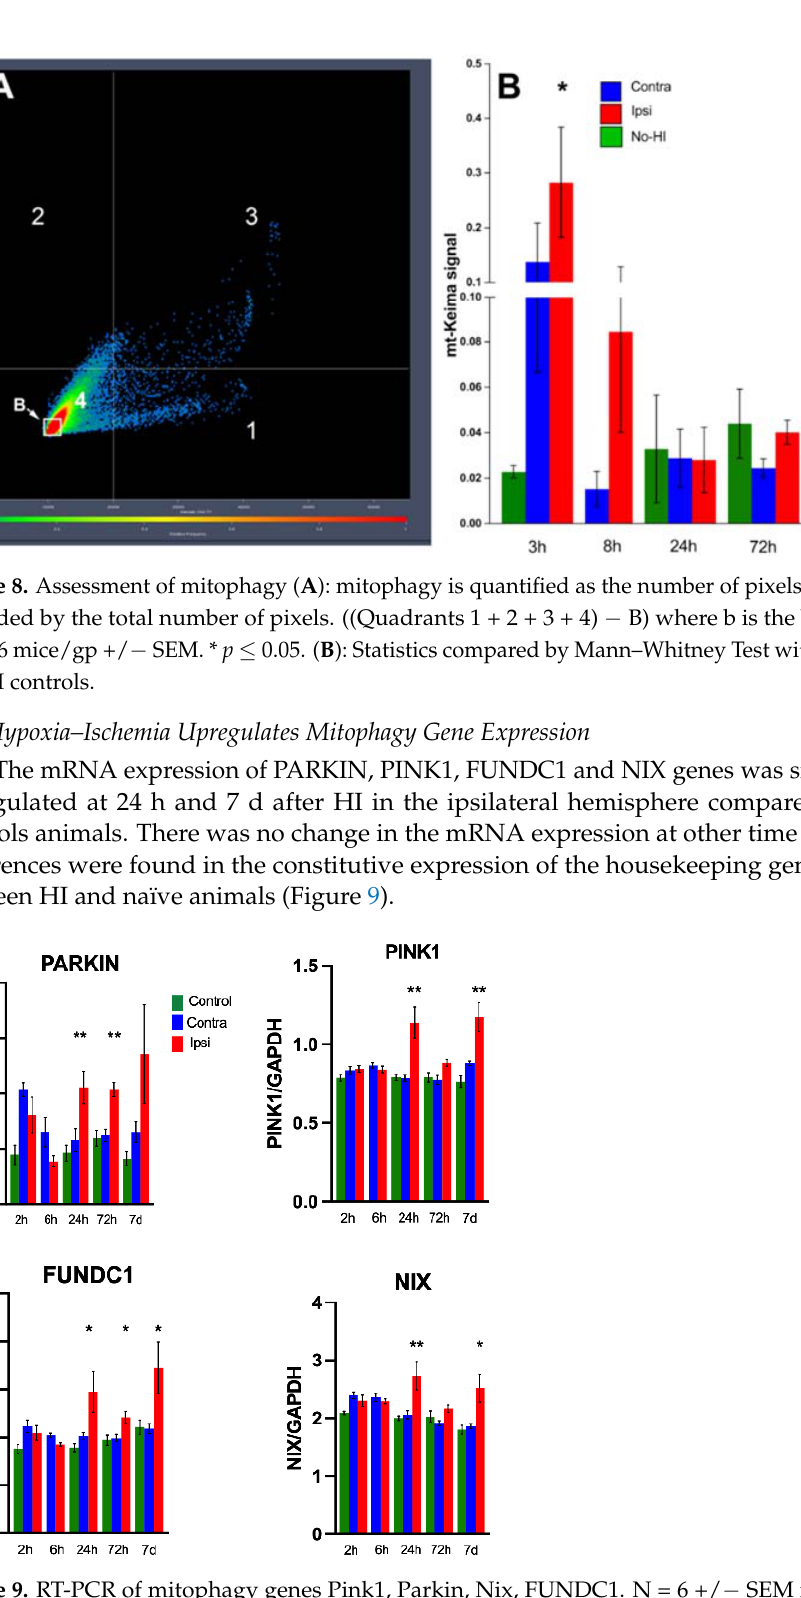
Figure 7. Assessment of mitophagy 7 days after HI in the brain tissue of mt ‐ Keima mice by super ‐ resolution microscopy; (( A ), A1–A3) uninjured hemisphere; (( B ), B1–B3) injured hemisphere; serial sections are visualized at 100 μ m intervals (indicated in dashed rectangles) of both hemispheres.